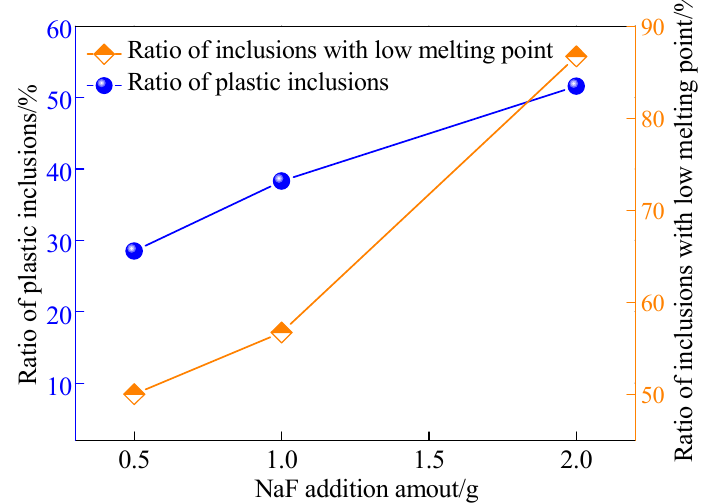
Figure 7. Relationship of the melting performance and deformability of inclusions with NaF addition.